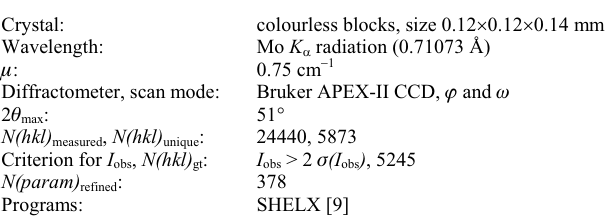
Table 1. Data collection and handling.